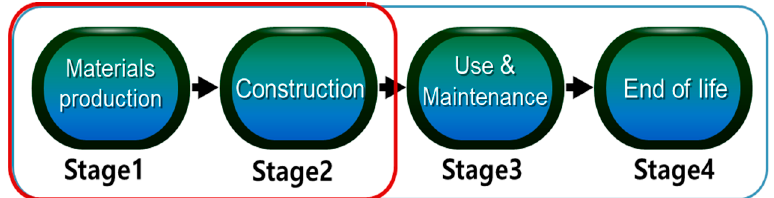
Figure 1. The four stages of tunnel CO 2 emission.